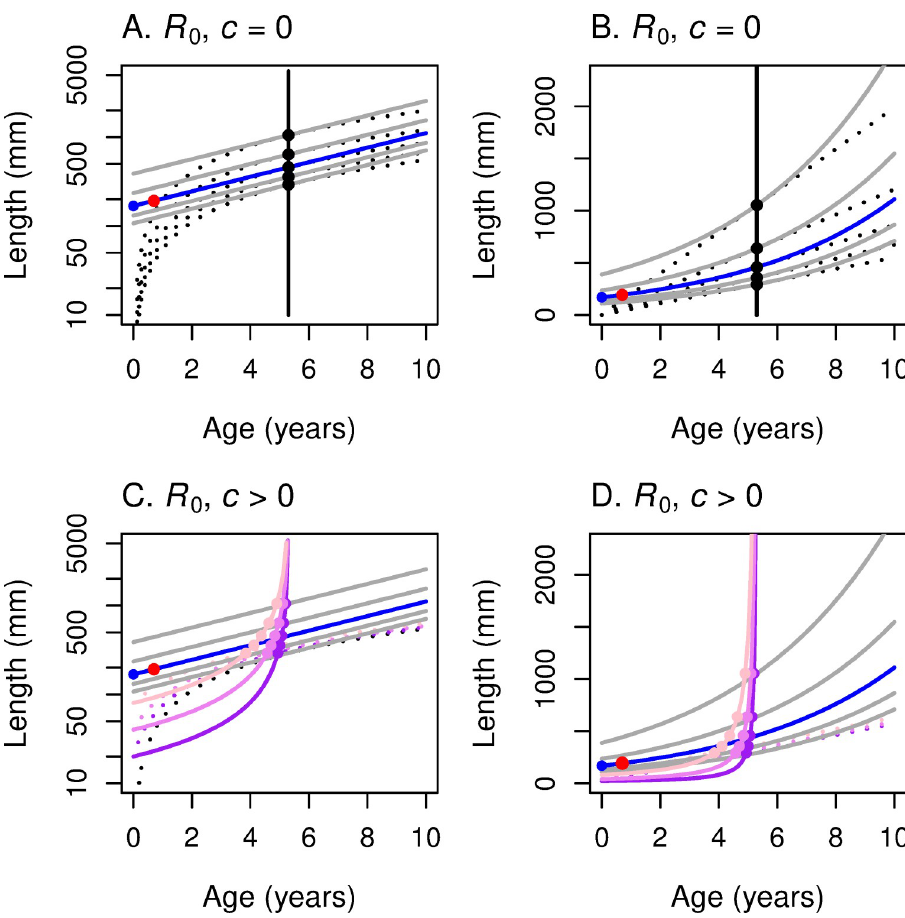
Fig 2. These panels illustrate the construction of the maturation reaction norm MRN( R 0 ) for linear growth. For linear growth: L = c + k x , where L is length, x is age in years, k is the growth rate, and c the size at age 0. The underlying fitness function is R 0 for all four panels. (A, C) The y -axis represents log-length so that the iso-fitness curves (solid grey lines) are straight lines. (B, D) The y -axis represents linear length so that the linear growth curves (black dotted lines) are straight lines. Size c at x = 0 is set to 0 in the first row; c > 0 in the second row (purple: 20 mm; violet: 40 mm; pink: 80 mm). (The analysis is much simpler for c = 0.) Higher growth curves correspond to higher values of the growth rate k . For each growth curve, one finds the highest iso-fitness curve that intersects it. The locus of such points as k varies traces out the reaction norm (solid black curve for c = 0, colored lines for c > 0). The reaction norm is mostly vertical when R 0 is the fitness function (versus perfectly horizontal when r is the fitness function; Fig 3). Fig 4 summarizes and consolidates this